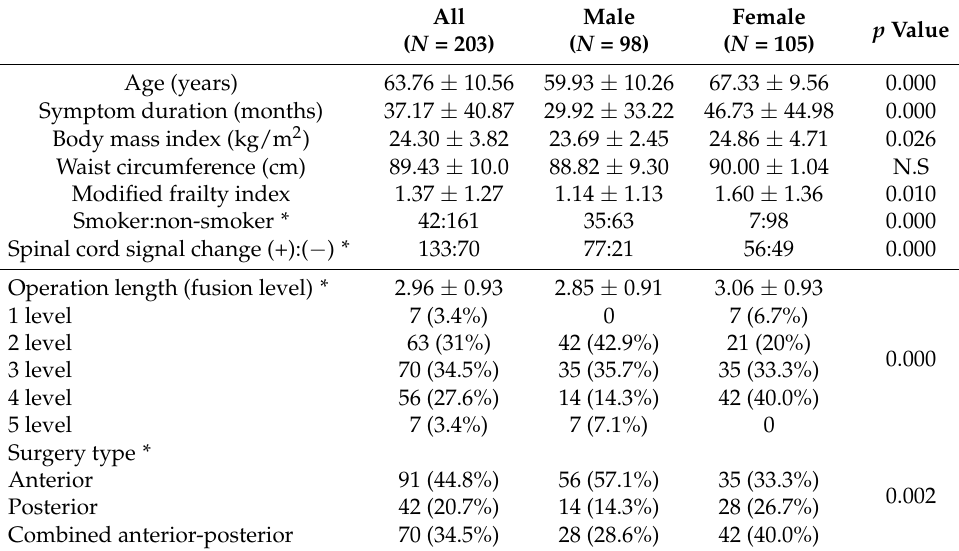
Table 1. Demographic parameters of the enrolled